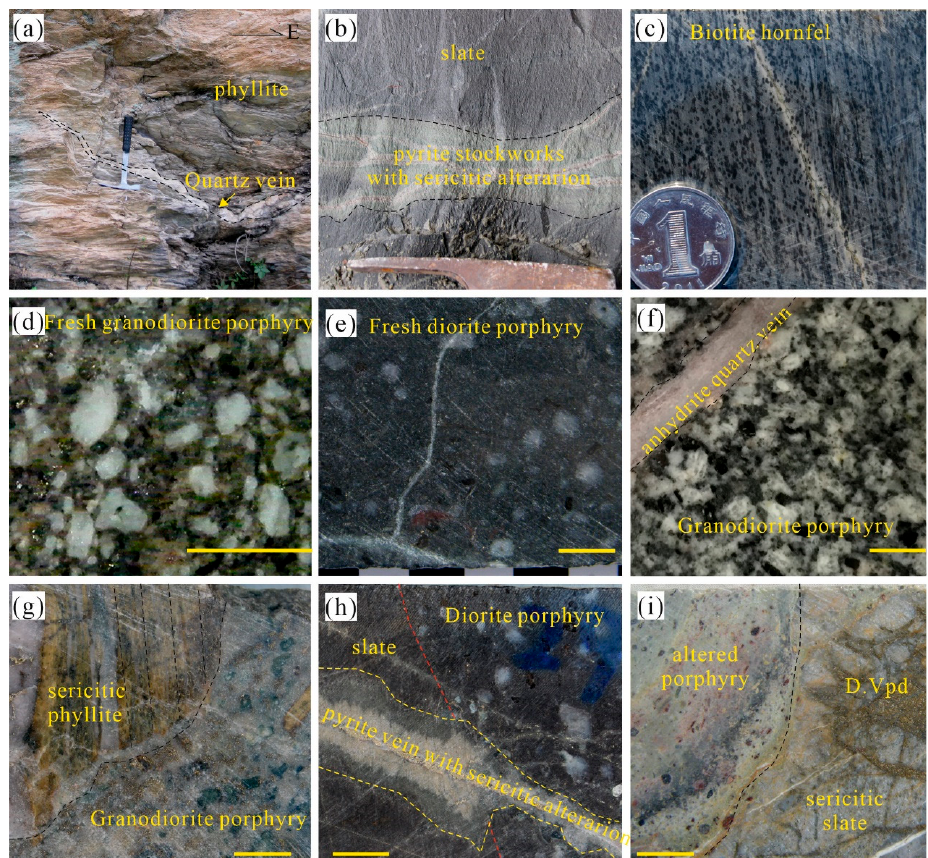
Figure 3. Major lithologies (phyllite, slate, hornfel, and porphyries) and their spatial relation at the Tongchang porphyry Cu deposit. ( a ) an outcrop of phyllite; ( b ) a slate with pyrite stockworks and sericitic alteration halo; ( c ) a biotite hornfel; ( d ) a fresh granodiorite porphyry; ( e ) a fresh diorite porphyry; ( f ) a granodiorite porphyry crosscut by an anhydrite quartz vein; ( g ) a granodiorite porphyry truncating phyllite, both of which are altered by sericitic alteration; ( h ) a dioritic porphyry truncating slate, both of which are crosscut by a pyrite vein; ( i ) an altered porphyry truncating D-type pyrite vein (D.Vpd) hosted in the slate. The scale in ( c ) is a Chinese one-dime coin.